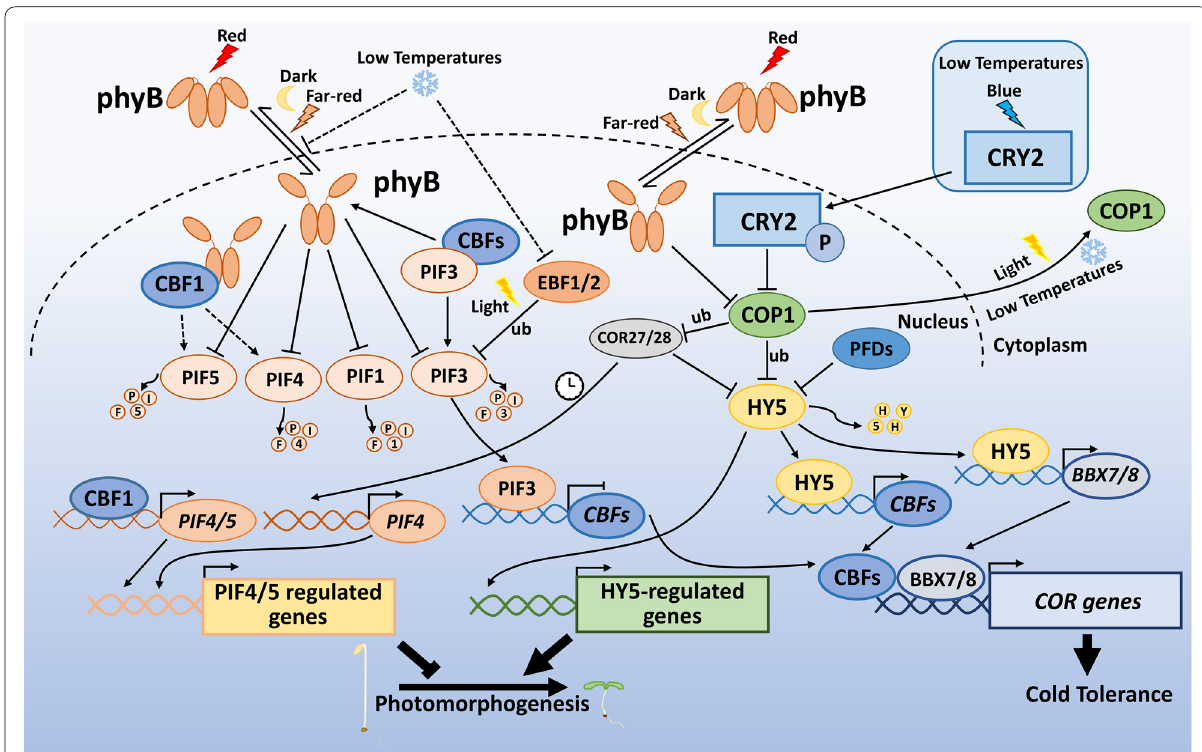
Fig. 1 PIFs and COP1-HY5 regulatory modules integrate light and low temperature signaling. Low temperatures negatively affect the light-triggered degradation of PIF3 by EBF1/2, allowing the accumulation of PIF3 that directly binds to the promoters of CBF genes and represses their expression. Accumulated CBFs interact with PIF3 to prevent concurrent degradation of PIF3 and phyB. Cold-stabilized phyB promotes the degradation of PIF1, PIF4, and PIF5. Upon red light irradiation, CBF1 interacts with phyB and promotes the accumulation of PIF4 and PIF5 at both transcriptional and protein levels. Cold- and blue light-induced COR27 and COR28 up-regulate the PIF4 expression in a circadian clock dependent manner. PIF4 and PIF5 regulate downstream target genes’ expression to repress photomorphogenesis. Light and low temperatures trigger the COP1 translocate from the nucleus to the cytoplasm. Low temperatures stabilize blue light-induced phosphorylated CRY2 that interacts with COP1 to compete with HY5. Consequently, these events lead to the accumulation of HY5. Accumulated HY5 activates the transcription of BBX7 and BBX8 to positively regulate freezing tolerance by controlling a set of COR genes’ expression. In parallel, HY5 regulates the expression of numerous target genes to promote photomorphogenesis. ub indicates